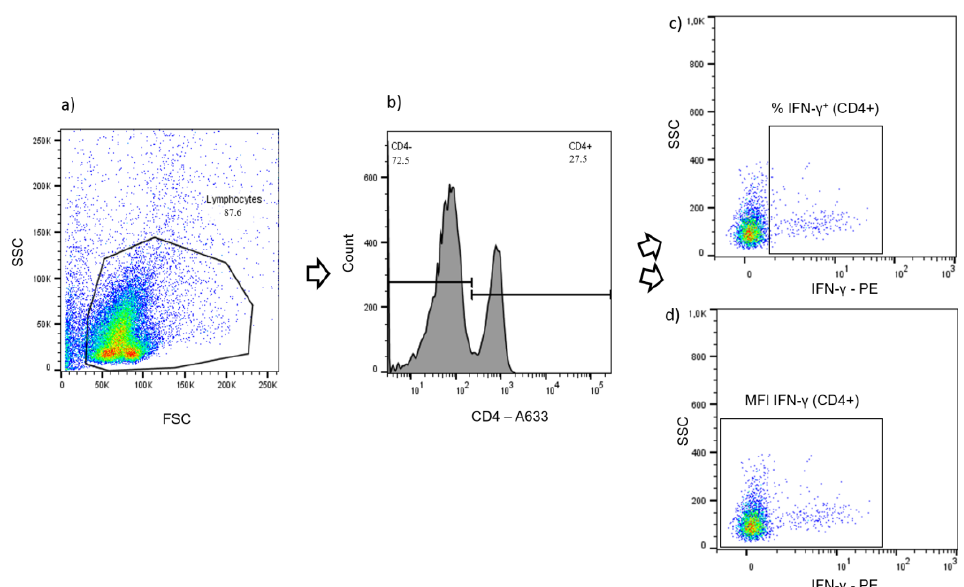
Figure 10. Flow cytometry gating strategy (representative example). ( a ) Gating for live and morpho- logically intact lymphocytes (density plot). ( b ) Gating for the CD4 + population (histogram). ( c ) Gating for the percentage of IFN- γ + cells within the CD4 + population (density plot). ( d ) Gating configu- ration for the determination of the median fluorescence intensity (MFI) for the detection of IFN- γ in all CD4 + T cells (density plot).